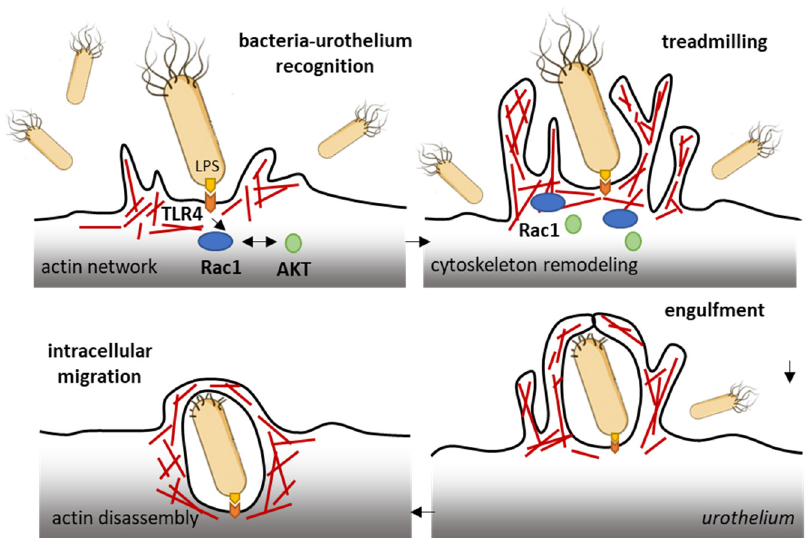
Figure 3. Rac1 plays a role in the invasion of bladder epithelial cells by type 1 fimbriated E. coli. Bacterial lipopolysaccharides activate the TLR4/Rac1/Akt signaling pathway to enter cells vascular smooth muscle cells and colonize the bladder tissue [54]. The Rac1 GTPase-mediated contributes to actin cytoskeleton remodeling and regulation of actin filaments.